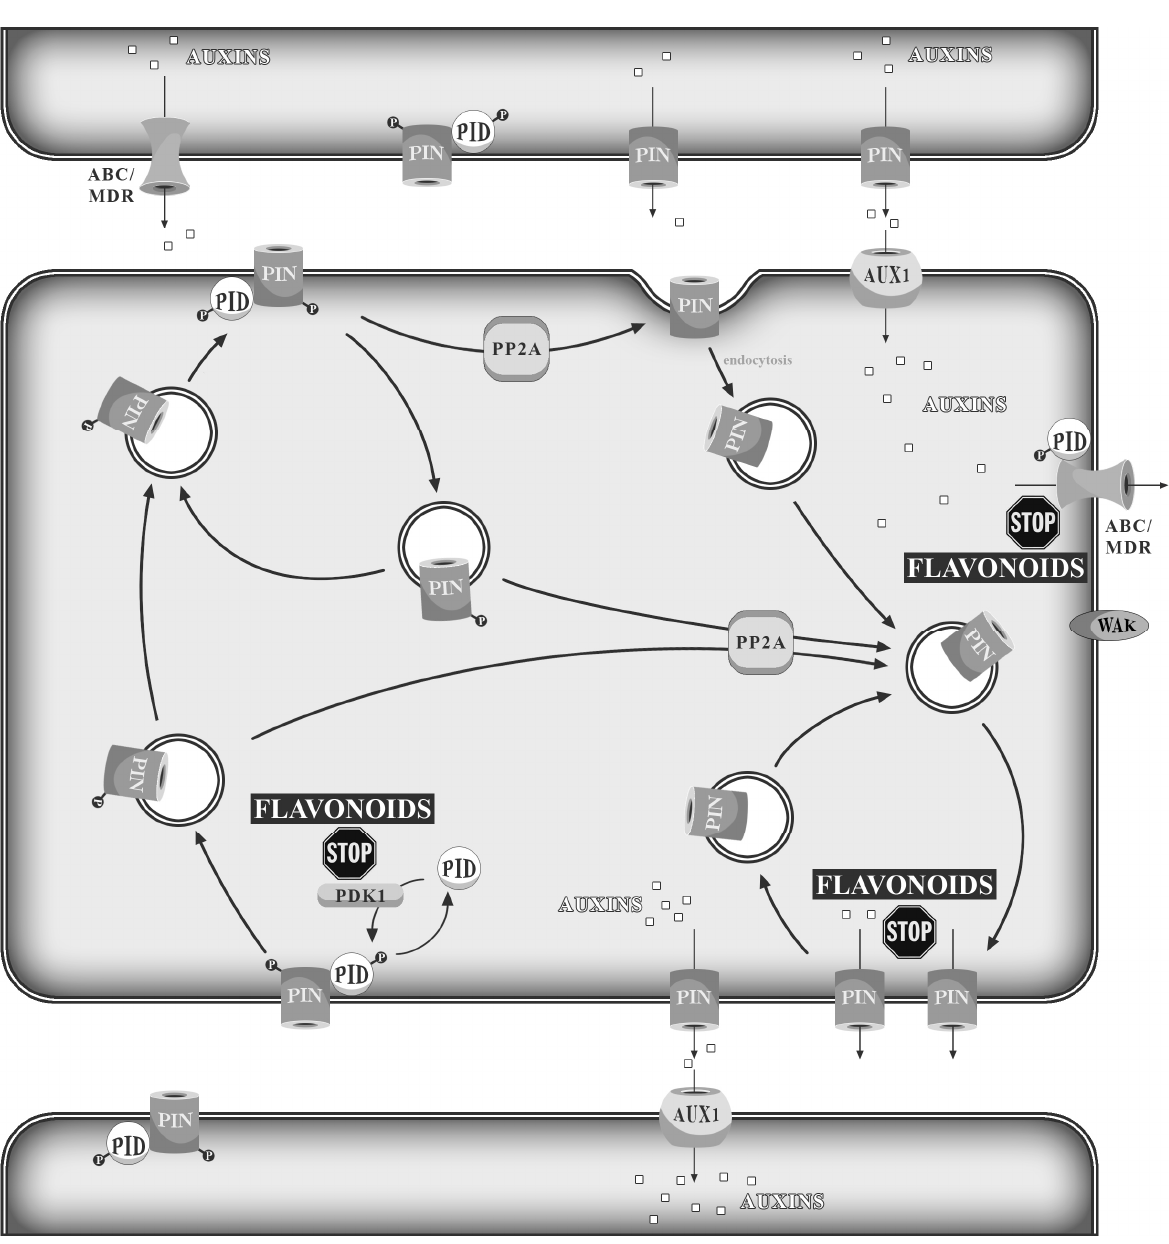
Figure 3. Flavonoids’ interference with PIN and MDR/ABC proteins, as well as with PID, WAK and PDK1 kinases leads to impaired auxin